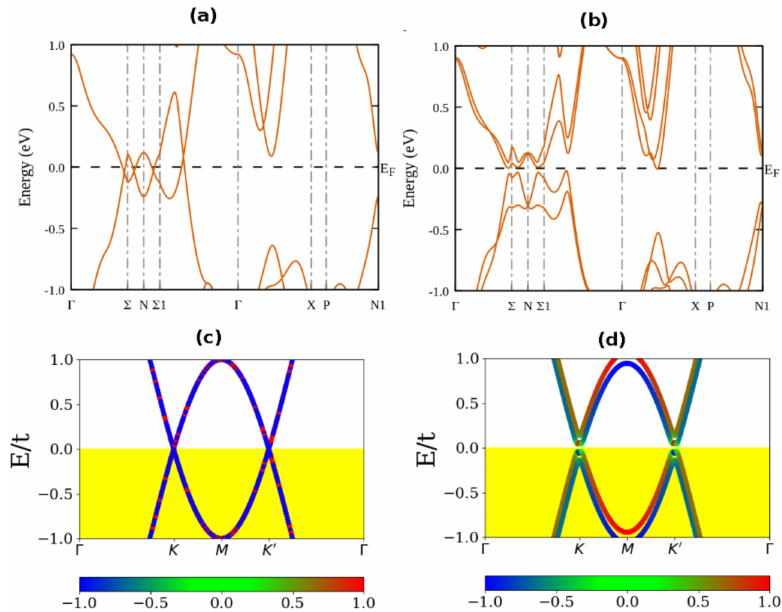
Figure 1. The DFT electronic structure of bulk TaAs in the absence of SOC ( a ). In the presence of SOC ( b ). Where the dashed horizontal line denotes the Fermi level. The corresponding band structure of bulk TaAs renormalized to the graphene sheet in the absence of SOC ( c ). In the presence of SOC ( d ) at λ R / t = 0.04 t and exchange field M / t = 0.06 t , with the Fermi level located at E / t = 0 eV, where t denotes the rescaled unit of energy. The color bars in ( c ) and ( d ) denote the value of the spin texture in units of S Z , where ¯ h